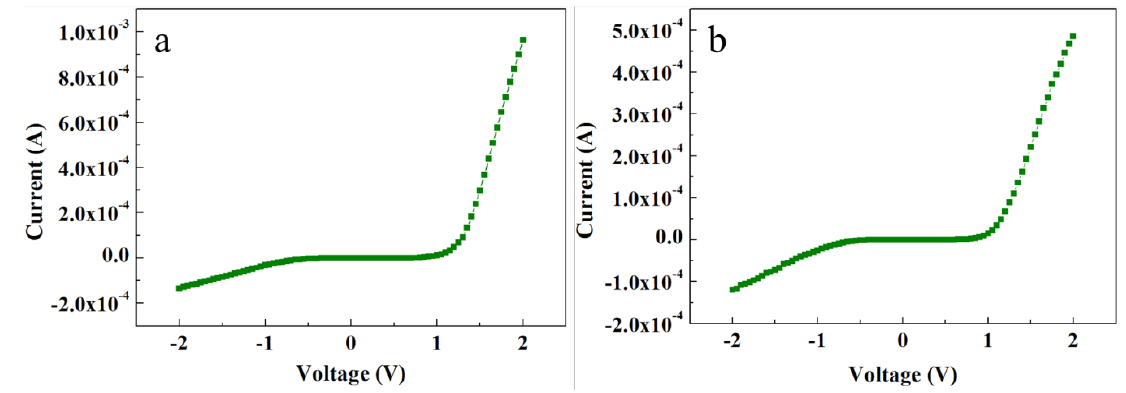
Figure 6. I-V characteristics of ( a ) OPT-ACG ZNRs and ( b ) MAG ZNRs. Figure 6. I - V characteristics of ( a ) OPT-ACG ZNRs and ( b ) MAG